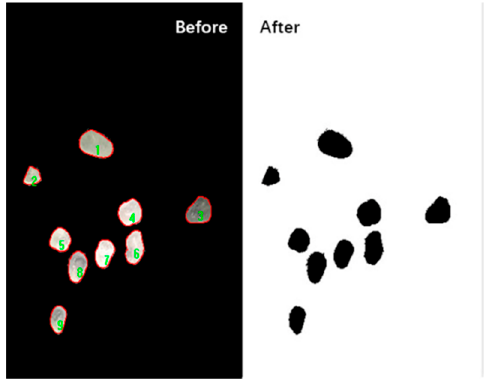
Figure 11. Image binarization. Figure 11. Image